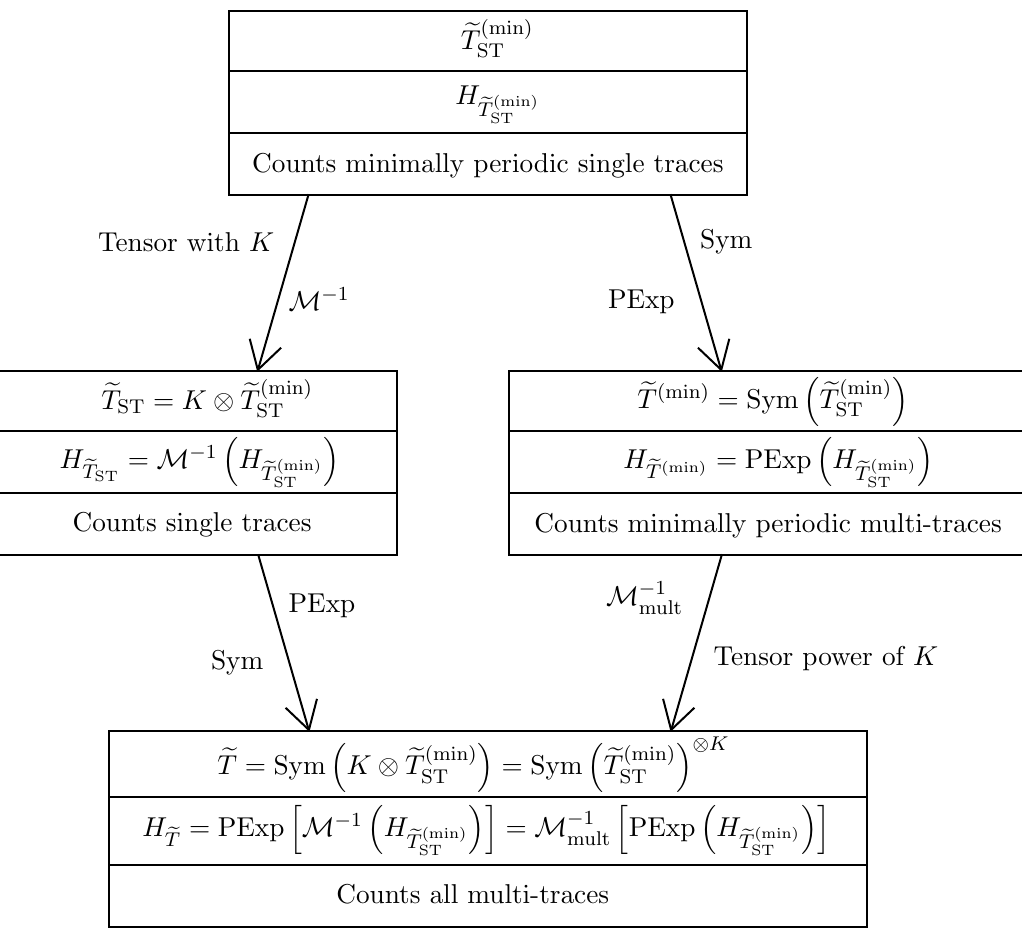
Figure 8 . Diagram summarising the structure of e T , the space of SO( N ) multi-traces, and its relation to e T (min) , the space of SO( N ) minimally periodic single traces. ST